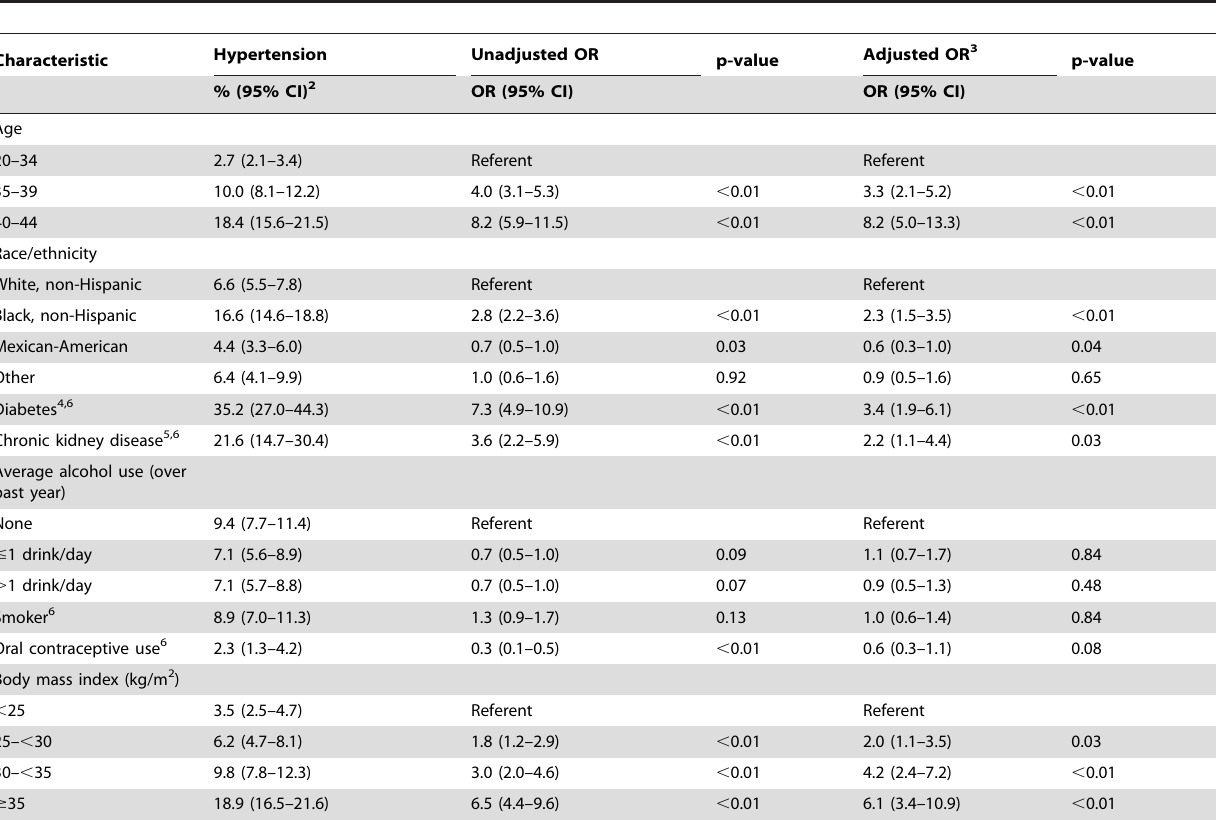
Table 2. Prevalence of hypertension 1 and unadjusted and adjusted odds ratios (OR) for risk of hypertension by characteristics of reproductive aged women, 20–44, United States, National Health and Nutrition Examination Survey, 1999–2008.